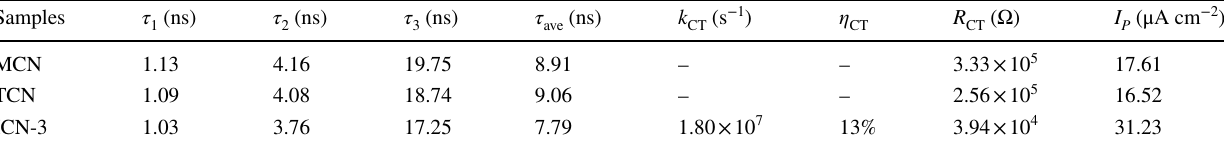
Table 1 The photogenerated charge lifetime ( τ 1 , τ 2 , τ 3 and τ ave ), transfer rate ( k CT ), transfer efficiency ( η C ), photogenerated charge transfer resist- ance ( R CT ) and photocurrent current density ( I P ) of samples Samples